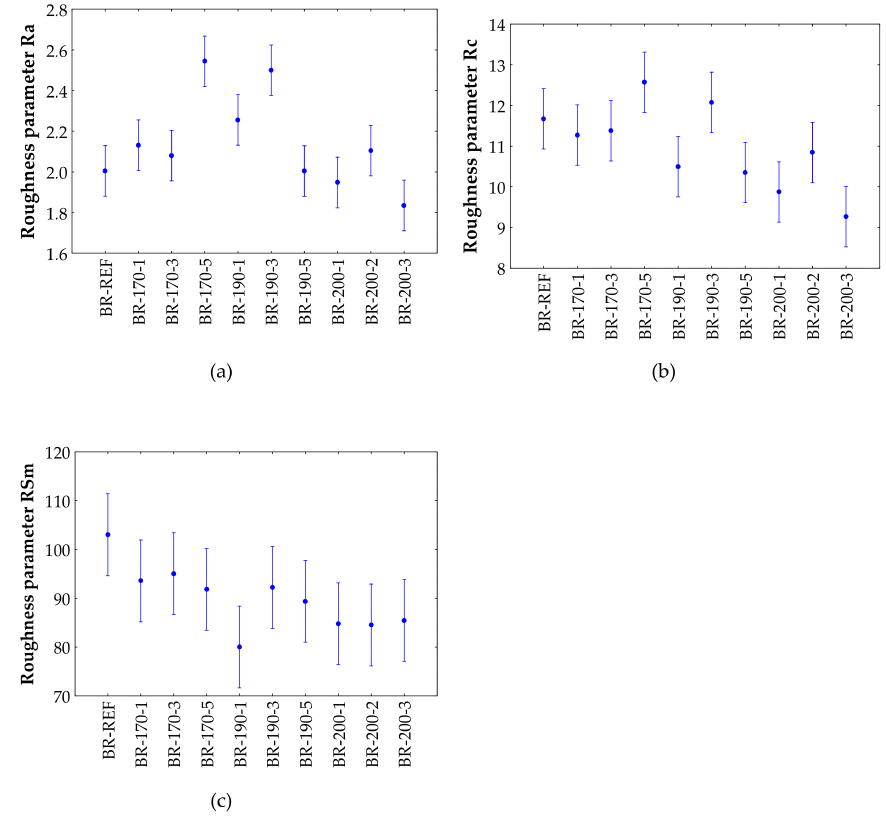
Figure 6. The graphic visualization of the e ff ect of heat-treatment temperature and heat-treatment time limit (peak stage) on roughness parameters determined by contact method ( a ) Ra, ( b ) RSm and ( c ) Rc. BR-REF = untreated birch; BR-170-1 = birch treated at 170 ◦ C / 1 h; BR-170-3 = birch treated at 170 ◦ C / 3 h; BR-170-5 = birch treated at 170 ◦ C / 5 h; BR-190-1 = birch treated at 190 ◦ C / 1 h; BR-190-3 = birch treated at 190 ◦ C / 3 h; BR-190-5 = birch treated at 190 ◦ C / 5 h; BR-200-1 = birch treated at 200 ◦ C / 1 h; BR-200-2 = birch treated at 200 ◦ C / 2 h; BR-200-3 = birch treated at 200 ◦ C / 3 h. Ra = the average arithmetical deviation of the profile; RSm = the average width of the profile elements; Rc = the average height of the profile.